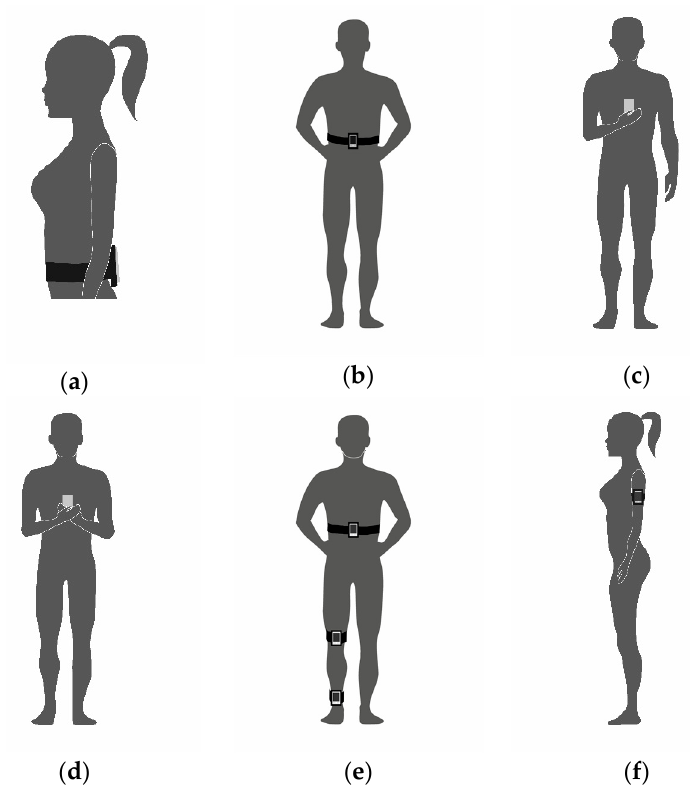
Figure 3. Devices and arms positions: ( a ) Lumbar or sacral region arms not reported [14,26]; ( b ) Lumbar or sacral region [15,27]; ( c ) Sternum dominated hand [30]; ( d ) Sternum both hands [17,28] ( e ) Malleolus, patella, umbilicus [18] ( f ) left upper arm [29].